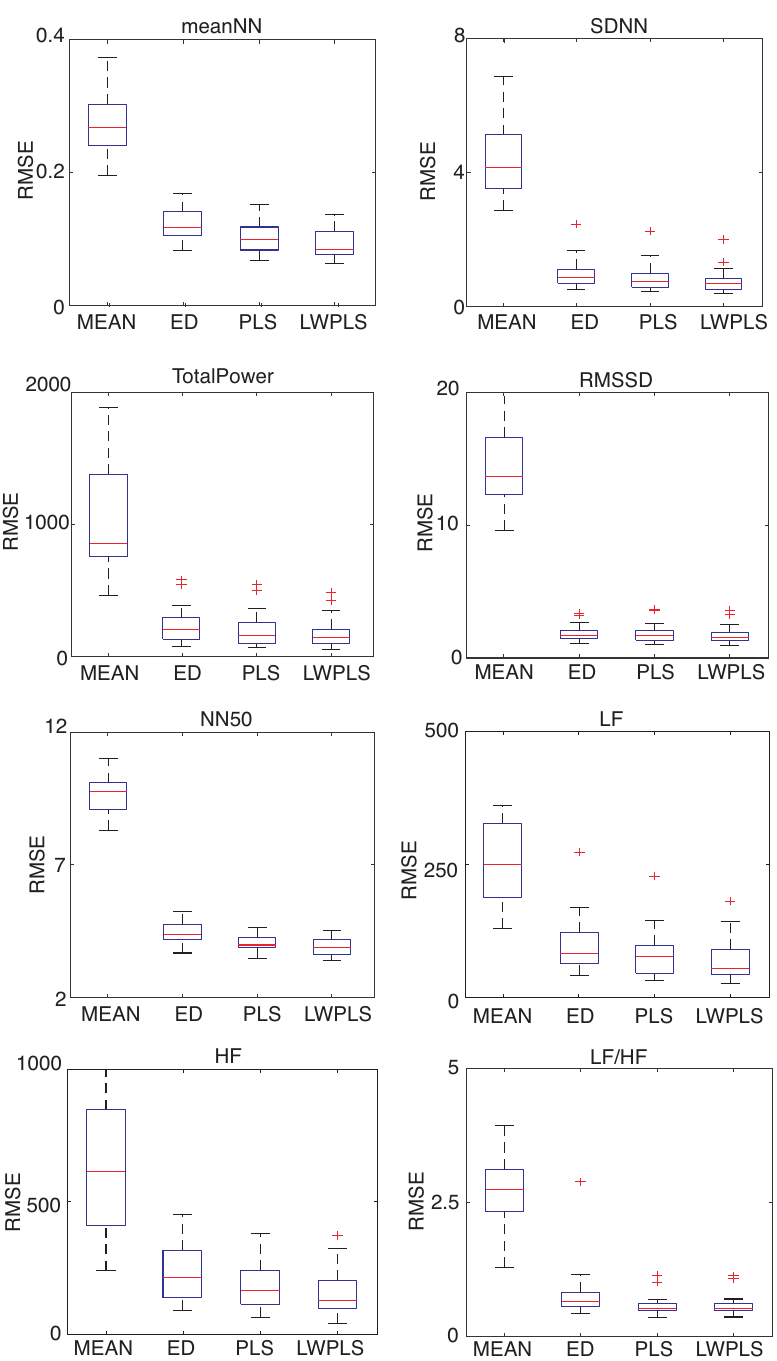
Figure 6. RMSE of HRV features derived from RRIs interpolated by MEAN, ED, PLS, and LWPLS when α = 0.3%. These eight HRV features were explained in the Appendix A. RMSEs of the four methods were calculated through a simulation repeated 30 times using all of the eighteen pieces. The proposed LWPLS-RI achieved the best HRV analysis